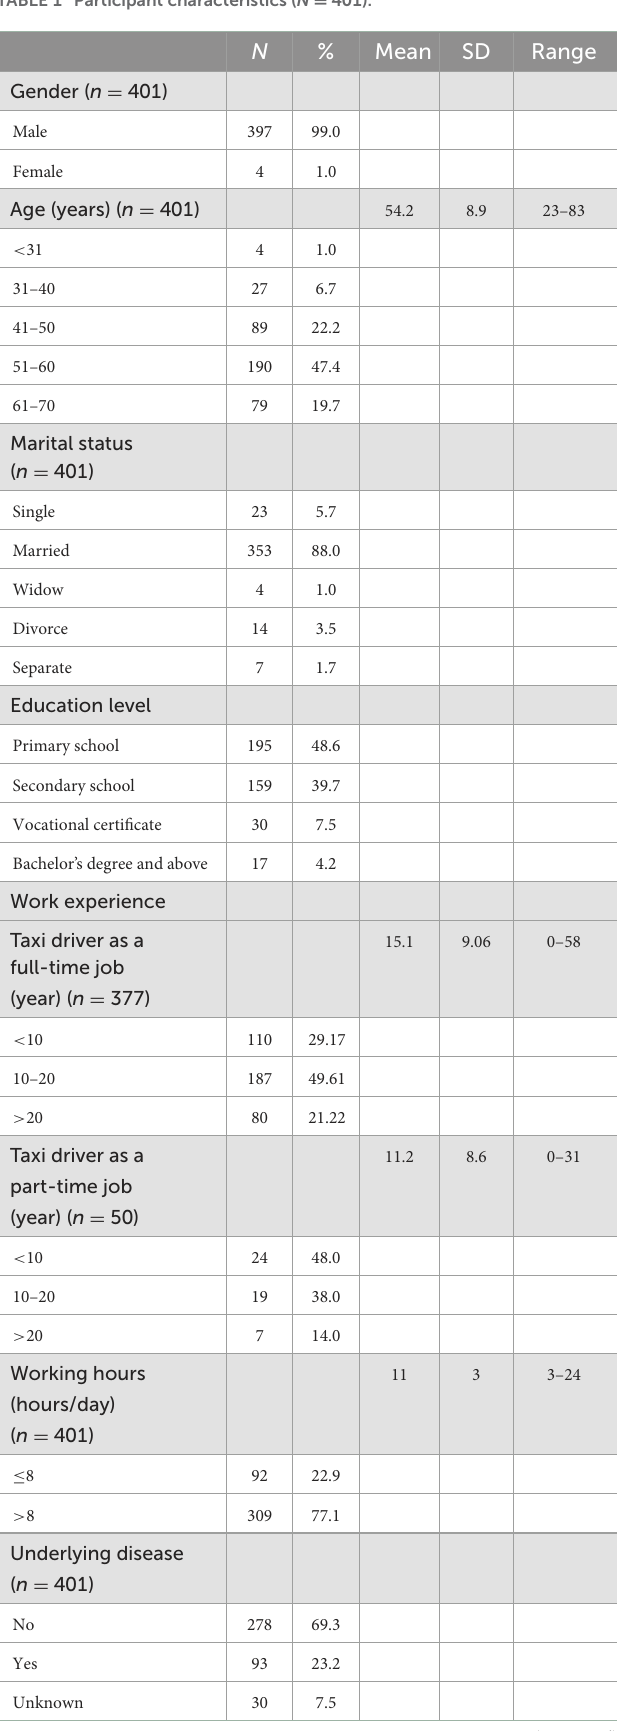
TABLE 1 Participant characteristics ( N =